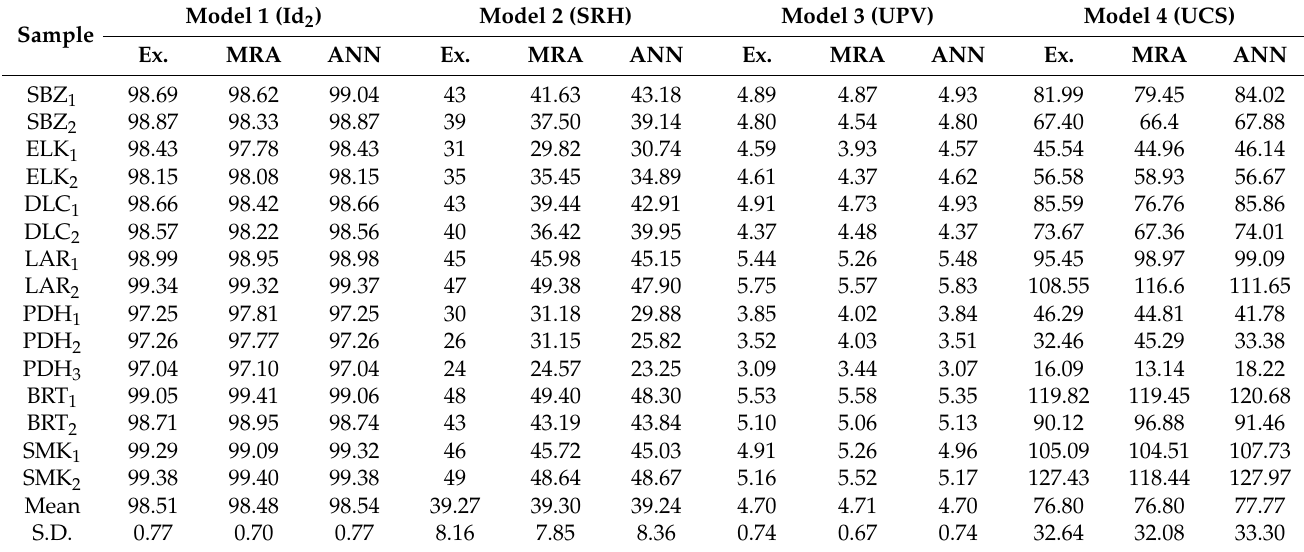
Table 11. Experimental and calculated values of Id 2 , SRH, UPV, and UCS obtained from the MRA and ANN